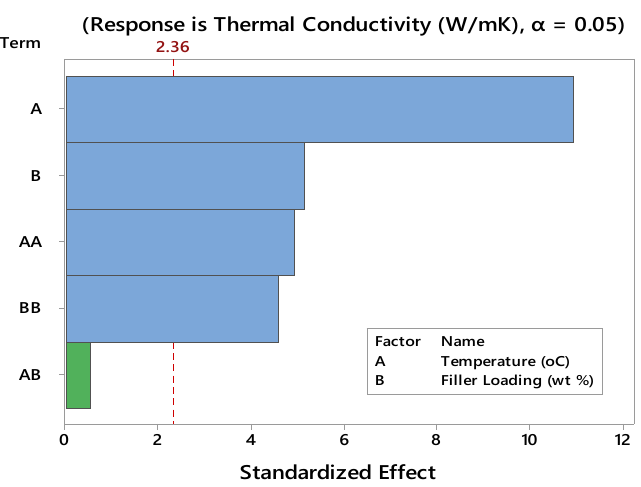
Figure 3. Pareto chart illustration of the standardized effect for thermal conductivity of the nanocomposites with a significant level shown by the dashed red line.